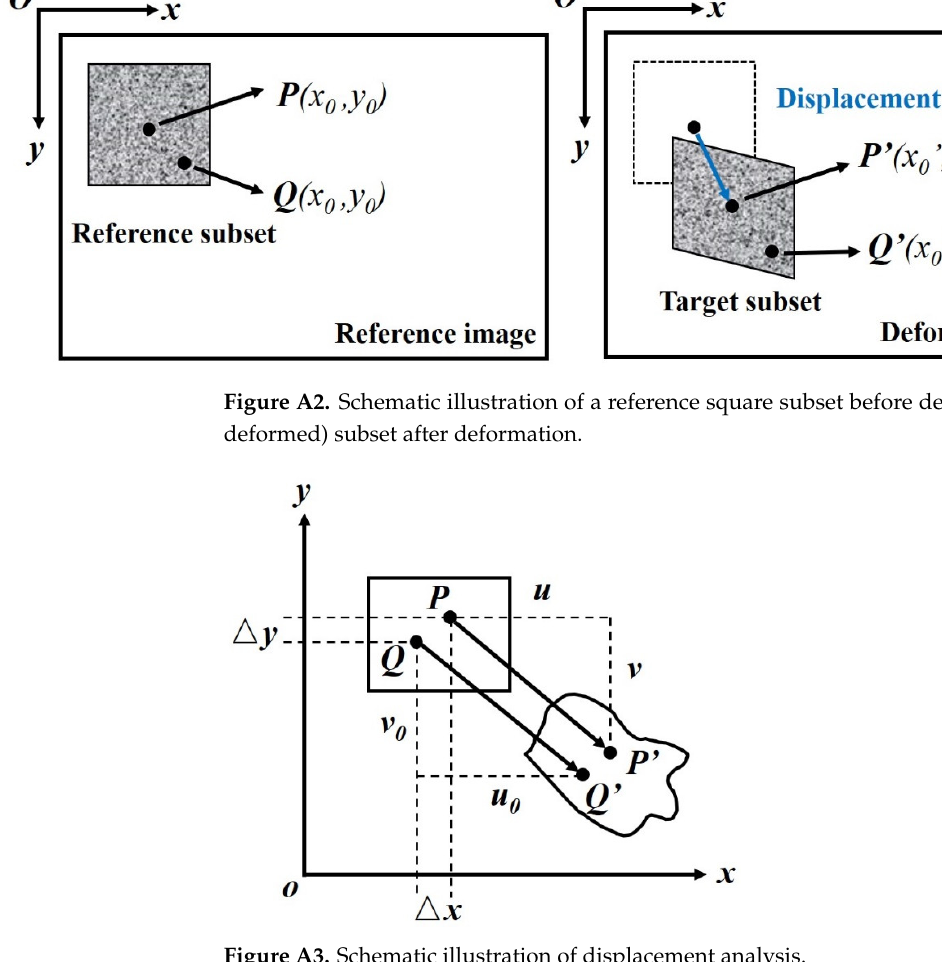
Figure A3. Schematic illustration of displacement analysis.